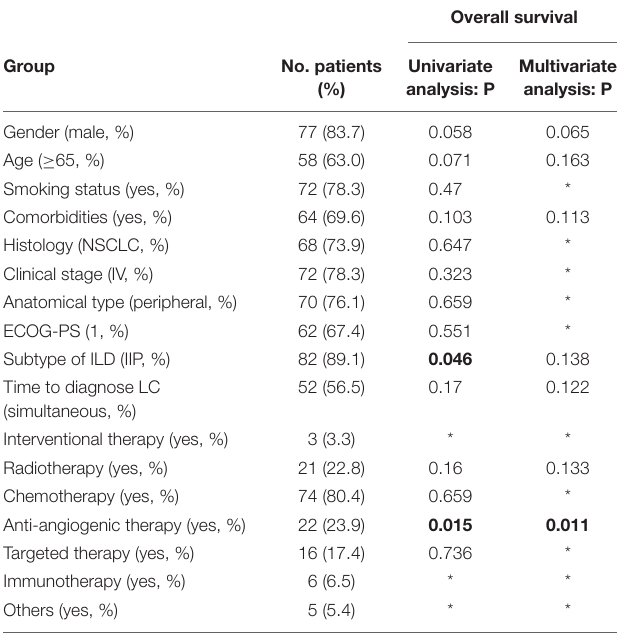
TABLE 4 | Clinical characteristics, univariate and multivariate analysis of 92 advanced lung cancer with ILD for overall survival.